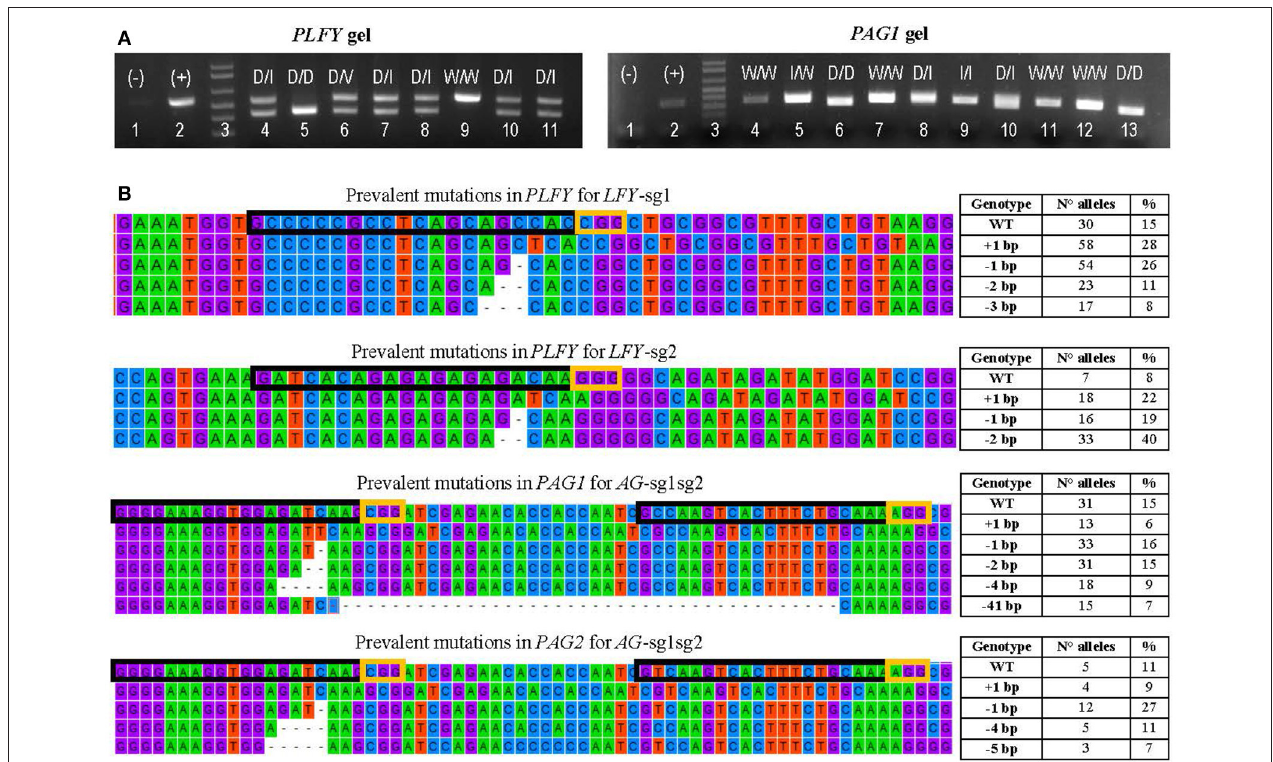
FIGURE 3 | Transformation event genotyping of LFY and AG paralogs. (A) Example of gels from PCRs of PLFY and PAG1 for insertion events with two sgRNAs. Symbols above each lane indicate the sequencing results of the DNA band(s). ( + ), positive control (–), negative control D, large deletion (16 or more base pairs); I, indel (insertion or deletion of 14 or fewer base pairs); V, inversion; W, wildtype. (B) Examples of the mutation types seen in alleles from mutants with one sgRNA in PLFY and two sgRNAs in PAG1 and PAG2. The top alignment shows the partial gene sequence of PLFY flanking LFY- sg1 in the coding region. The second from the top alignment shows the partial sequence of PLFY flanking LFY- sg2 in the promoter region. The third from the top alignment shows the partial sequence of PAG1 between AG- sg2 and AG- sg1. The bottom alignment shows the partial sequence of PAG2 between AG- sg2 and AG- sg1. The protospacer sequence (i.e., target site) is surrounded by a black box. The PAM sites are surrounded by a yellow box. The dashes indicate deleted base pairs. The tables on the right indicate the mutation seen in each row, the number of alleles with that mutation, and the percentage that the number represents in each